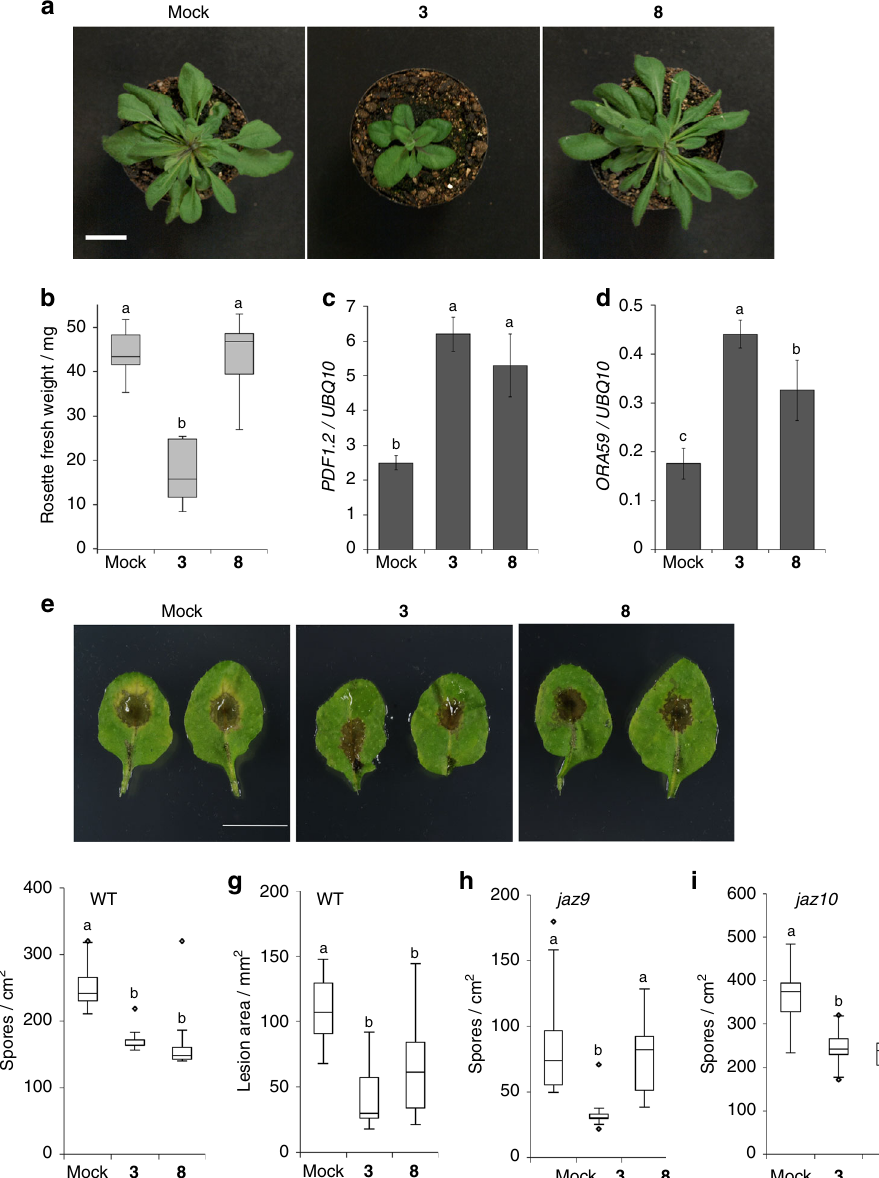
Fig. 5 Effects of 3 and 8 on plant growth and defense of adult Arabidopsis . a – d The effects of the repetitive treatment of the compounds ( 3 or 8 at 50 µ M, 5 times per week from 1-week-old to 5-week-old plants) in the aerial part of WT Arabidopsis adult plants grown for 5-week-old plants (see Supplementary Methods). Scale bar, 2 cm. The representative images of plants treated repetitively with 50 µ M of each compound ( a ), fresh weights of aerial parts of the ligand-treated adult plants ( b ), and gene expression level of the aerial parts of the ligand-treated adult plants ( c ; PDF1.2 , d : ORA59 ) ( n = 7). Signi fi cant differences were evaluated by one-way ANOVA/HSD post hoc test ( p < 0.05). Experiments were repeated three times with similar results. e – g Wild-type Col-0 plants were treated with mock solution, 3 or 8 (50 µ M) ( n = 11 – 20) and infected with A. brassicicola . Representative leaves of plants infected with A. brassicicola are shown in e . Scale bar, 10 mm. Quanti fi cation of fungal spores ( f ) and lesion area ( g ) was undertaken 6 days after inoculation; the results are depicted using box-plots; horizontal lines are medians, boxes show the interquartile range and error bars show the full data range. Outliers are indicated as circles. Asterisks above columns indicate signi fi cant differences compared to the mock-treated values evaluated by one- way ANOVA/Tukey HSD post hoc test ( p < 0.05). Experiments were repeated three times with similar results. h – i jaz9 and jaz10 mutant plants were treated with mock solution, 3 or 8 (50 µ M) ( n = 14 – 20) and infected with A. brassicicola . Quanti fi cation of fungal spores was undertaken 7 days after inoculation; the results are depicted using box-plots as described in f . Asterisks above columns indicate signi fi cant differences compared to the mock- treated values analyzed by one-way ANOVA/Tukey HSD post hoc test ( p < The expression of PDF1.2 and additional ORA59 / ERF - Fig. 5a, b, repetitive addition of 3 induces strong growth regulated defense response genes plays a crucial role in plant inhibition on the aerial part of 5-week-old plants, whereas 8 defense against fungal pathogens 6 . Therefore, we assessed the did not. In contrast, both 3 and 8 activate the gene expression of effect of 8 , on plant defense against the fungus Alternaria PDF1.2 or ORA59 in the same way (Fig. 5c, d). Subsequently, brassicicola, as well as on growth of the adult plants. As shown in treatment of the plant with COR ( 3 ) induced plant resistance